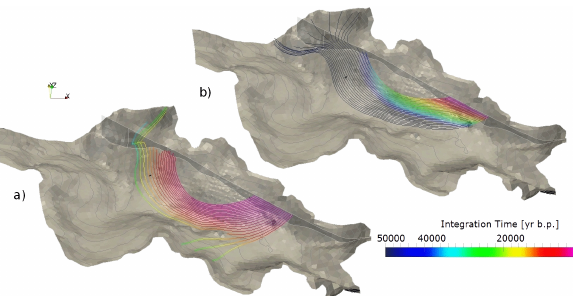
Fig. 8. Age (dots) distribution obtained with the anisotropic flow law using (a) depth-dependent fabric distribution and (b) single maximum fabric for integration times of 15kyr.